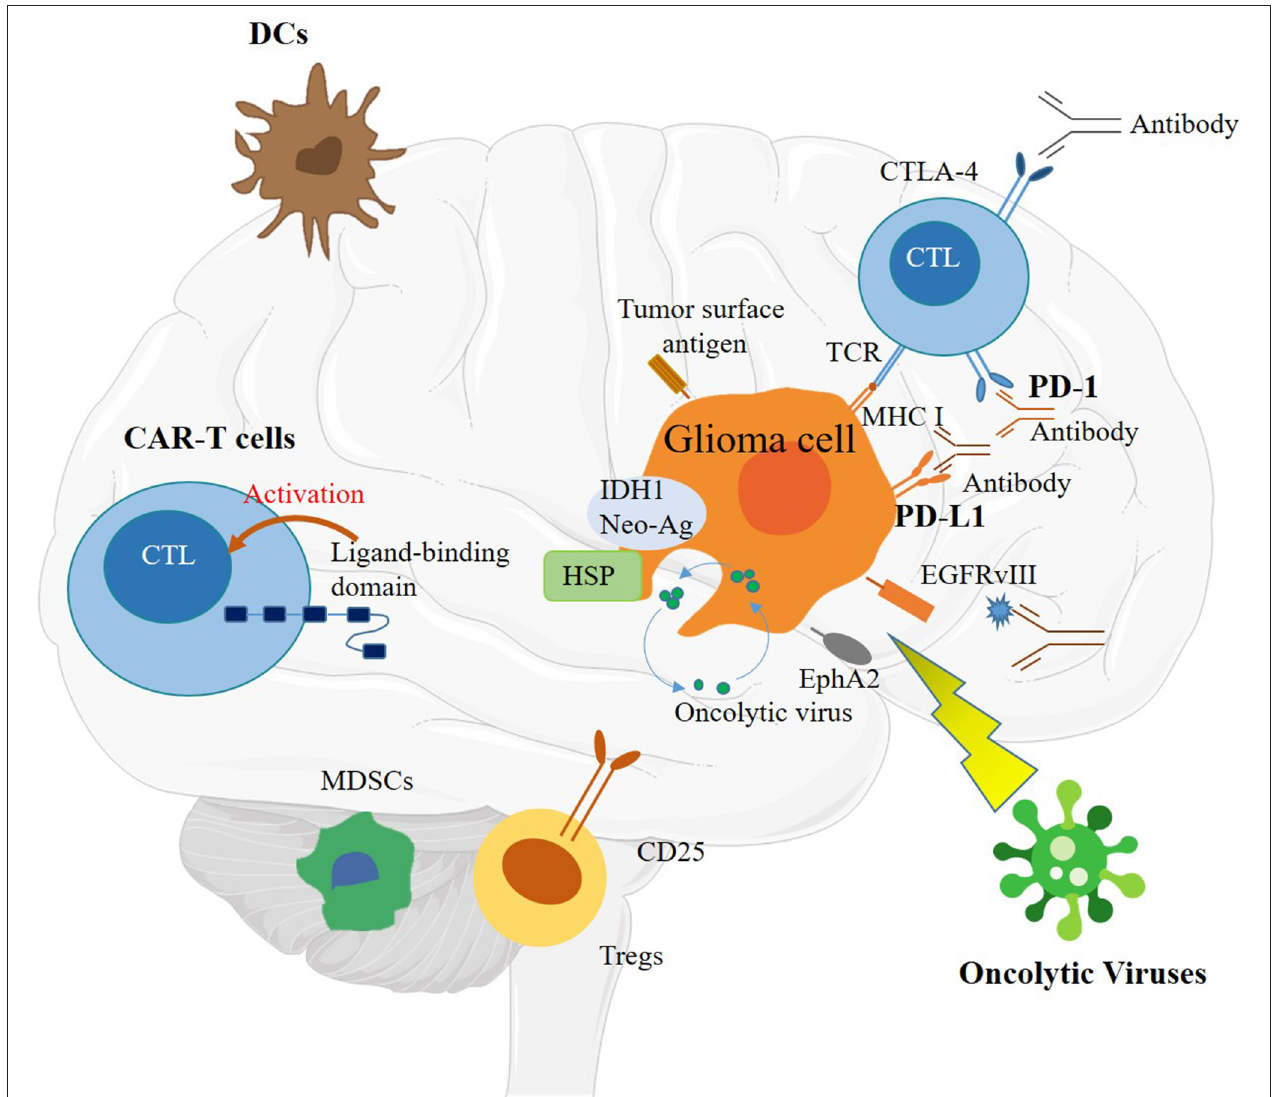
FIGURE 2 | Schematic of immunotherapy, including immune checkpoint inhibitors, dendritic cell (DC) vaccines, chimeric antigen receptor (CAR) T cells, and oncolytic viruses